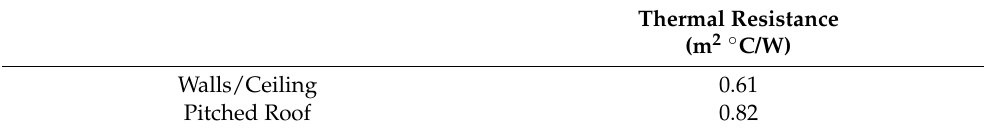
Table 1. Thermal properties of the test cells.